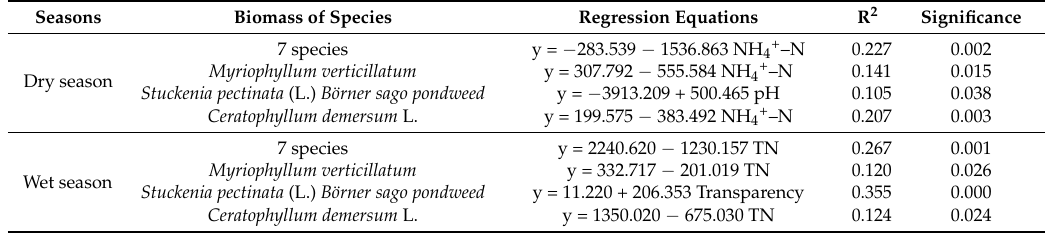
Figure 7. Spatial variability in TN, TP and biomass in the dry season: ( a ) TN; ( b ) TP; and ( c ) Biomass. Table 4. Responses of biomass of different submerged aquatic plants to various water quality parameters by multiple linear regression (MLR)